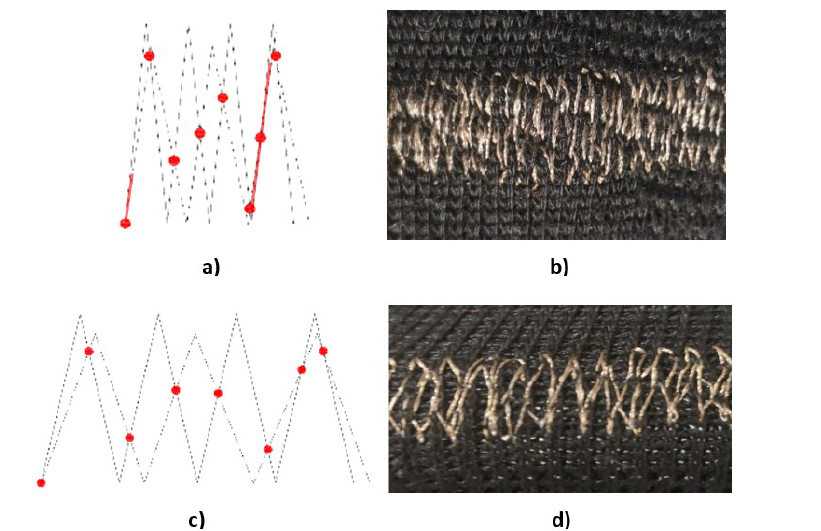
Figure 3. Details of zigzag A (continuous line) and zigzag B (dash line) embroidered pattern. Red dots or lines represent the electrical contact points or contact zones between both zigzag pattern ( a ) pattern without strain (low resistance) ( b ) real image of the pattern without strain ( c ) pattern under strain conditions (high resistance as result of an increase of the effective length) ( d ) real image of the pattern under strain